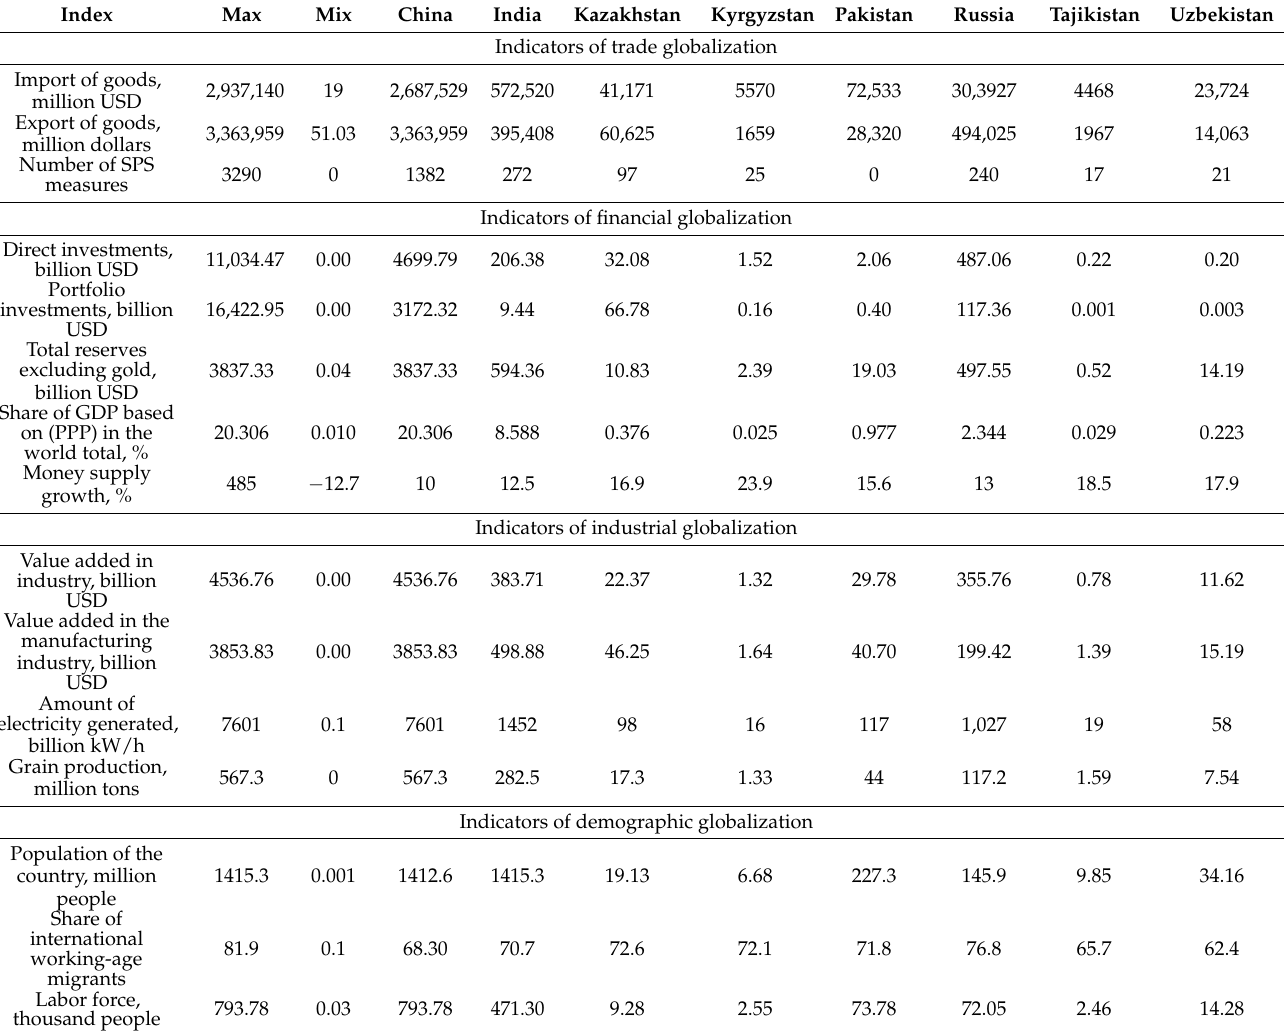
Table 3. The initial data for assessing the level of globalization of the SCO